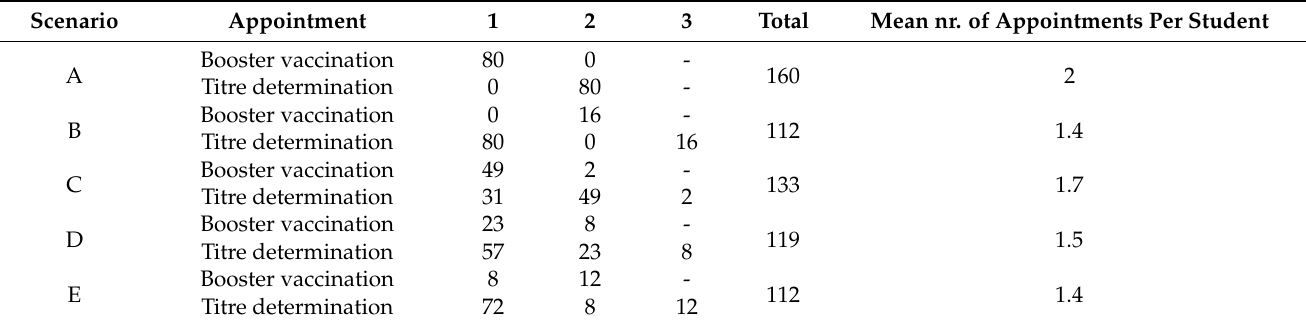
Table 2. Number of booster vaccinations and/or titre determinations per appointment in 5 different scenarios.